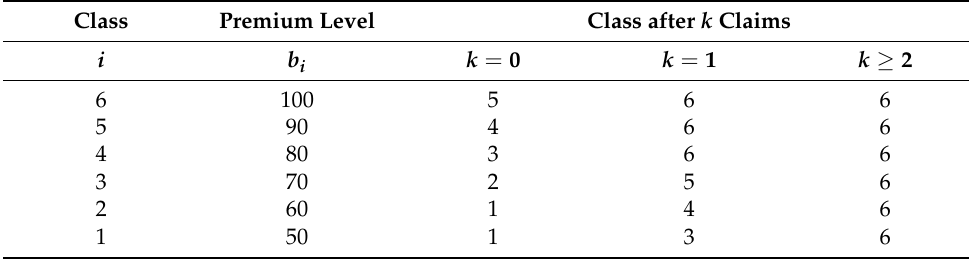
Table 2. Irish bonus-malus